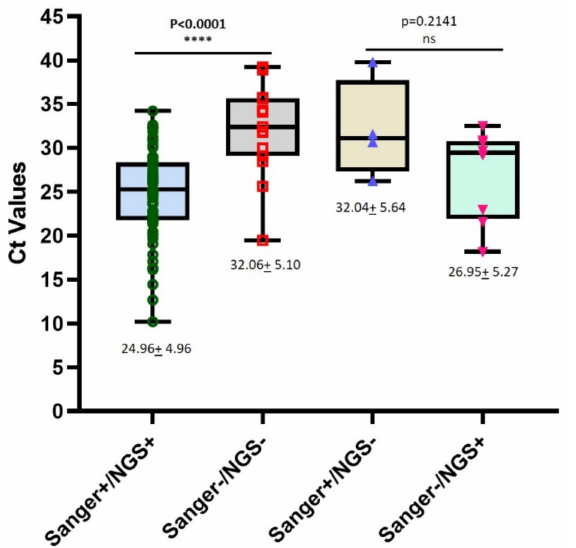
Figure 2. Box charts representing comparisons of EV RT-qPCR Ct values between samples with positive/negative EV typing results using conventional PCR followed by Sanger sequencing and mECRA RT-PCR followed by NGS analysis. Median and lower/upper quartiles are shown as lines inside and outside top/bottom edges of the box, respectively. Mann–Whitney U test was used to determine statistical significance; **** showing statistically significant result and ns showing statistically non-significant